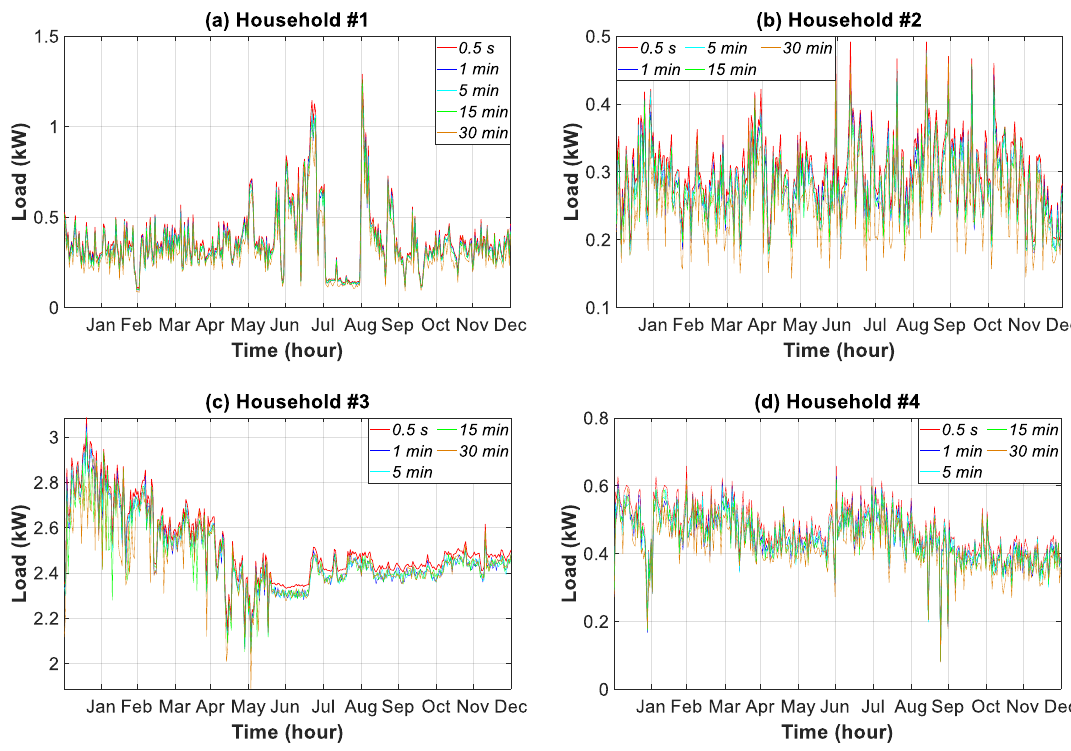
Figure 11. Daily average consumption load profile in households #1 to #4 for five data granularities.